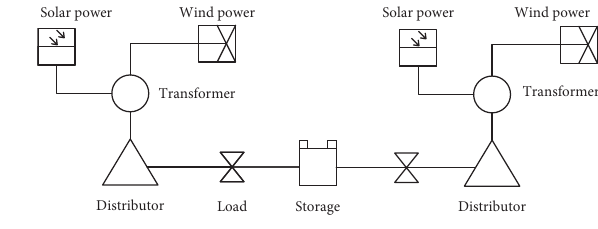
Figure 1: Energy node of DG.